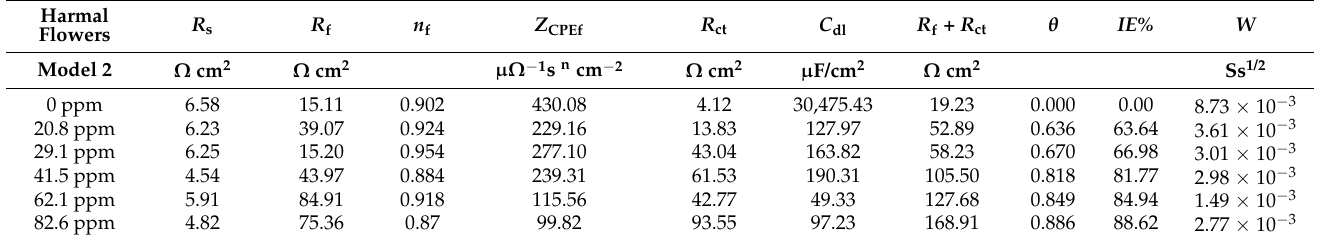
Table 6. Impedance parameters for the Harmal flower extract on the C-steel in 0.25 M H 2 SO 4 medium by fitting the equivalent circuit model